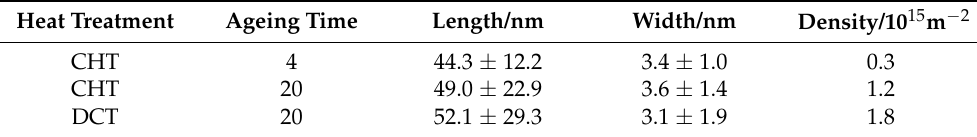
Table 3. Quantified precipitation data from TEM observations.